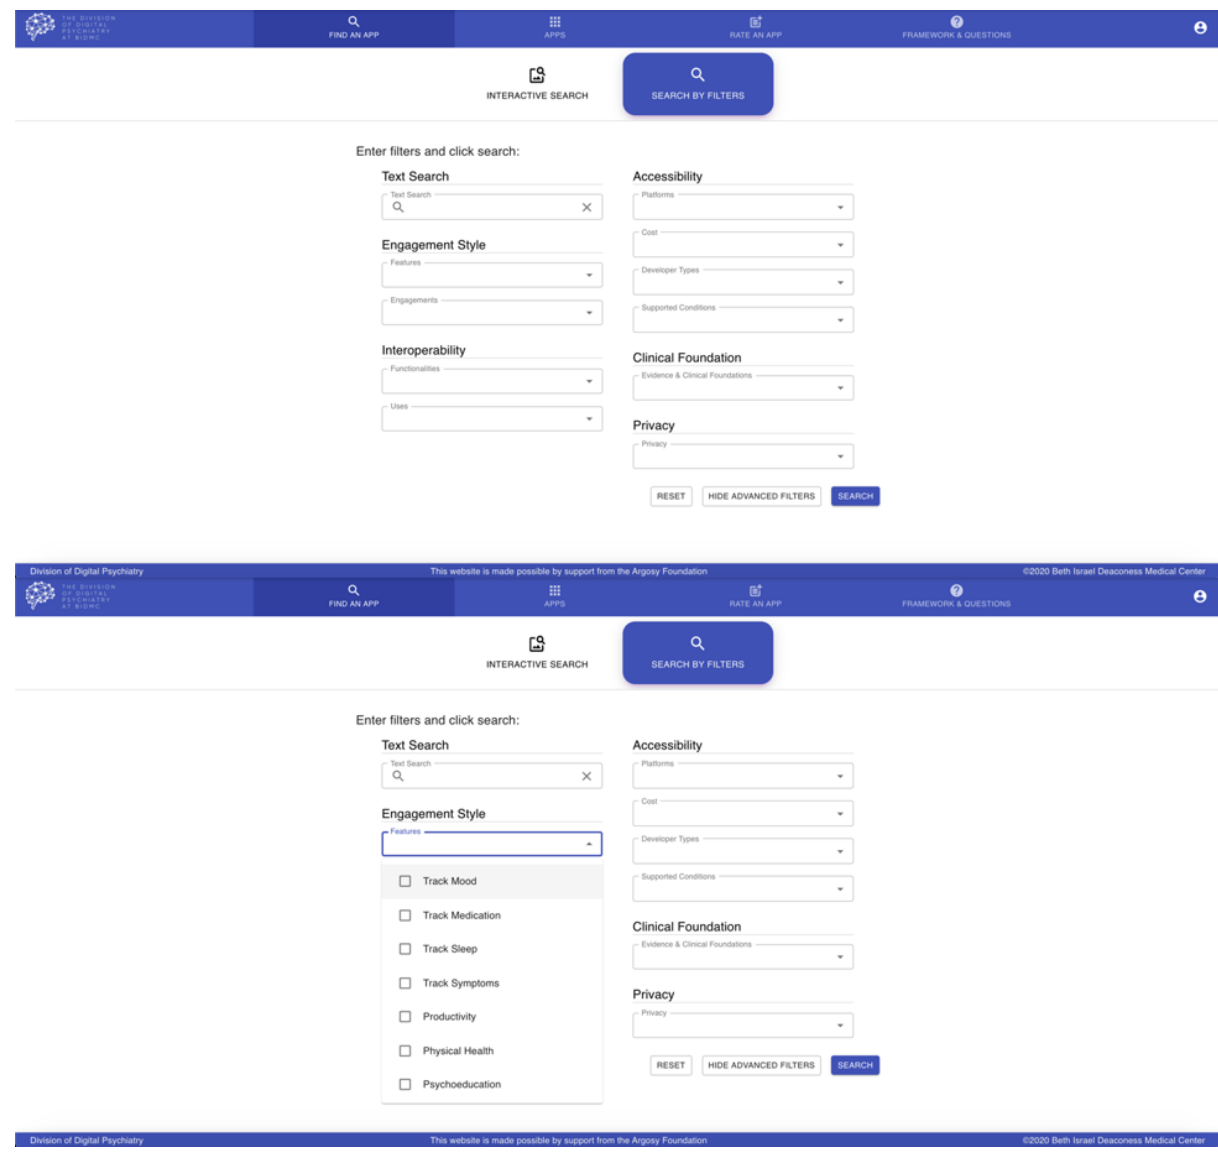
Figure 4. Screenshots of the database for smartphone app filtering. The top panel showcases the various filters that users can use to find an app. The lower panel displays some of the features users can choose under ‘Engagement Style.’The rest of the features in this category can be seen by scrolling on the